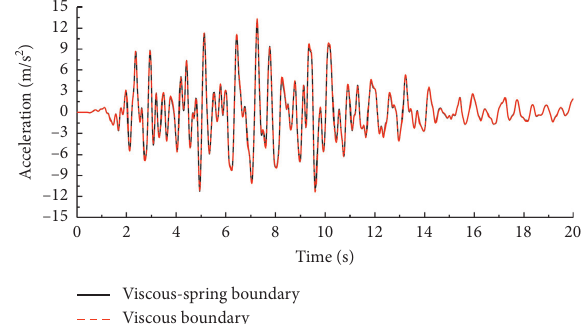
Figure 19: Time histories of horizontal accelerations of the Jin’anqiao dam at dam crest.